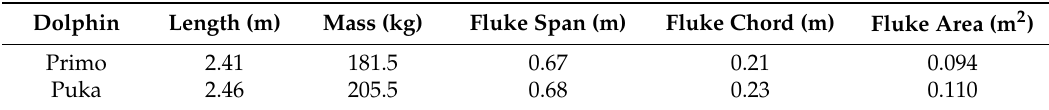
Table 1. Morphometrics of dolphins ( Tursiops truncatus )